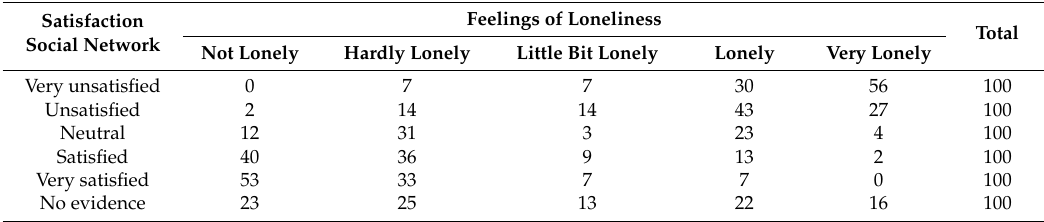
Table 8. Updated probabilities (in %) for feelings of loneliness based on level of satisfaction with social network.